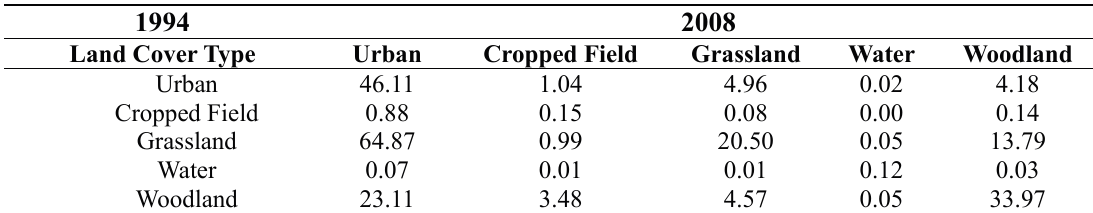
Table 12. Land conversions in Mukuvisi catchment between 1994 and 2008 (Area is in square